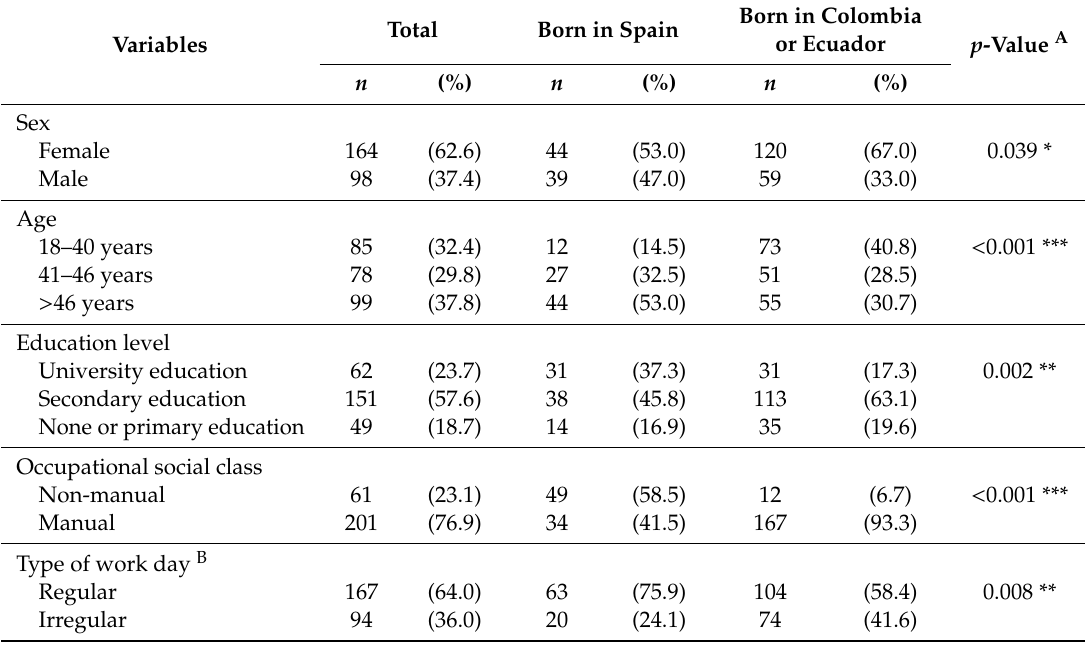
Table1. Distributionofworkersincludedinthestudybysociodemographiccharacteristics, occupational characteristics, and country of